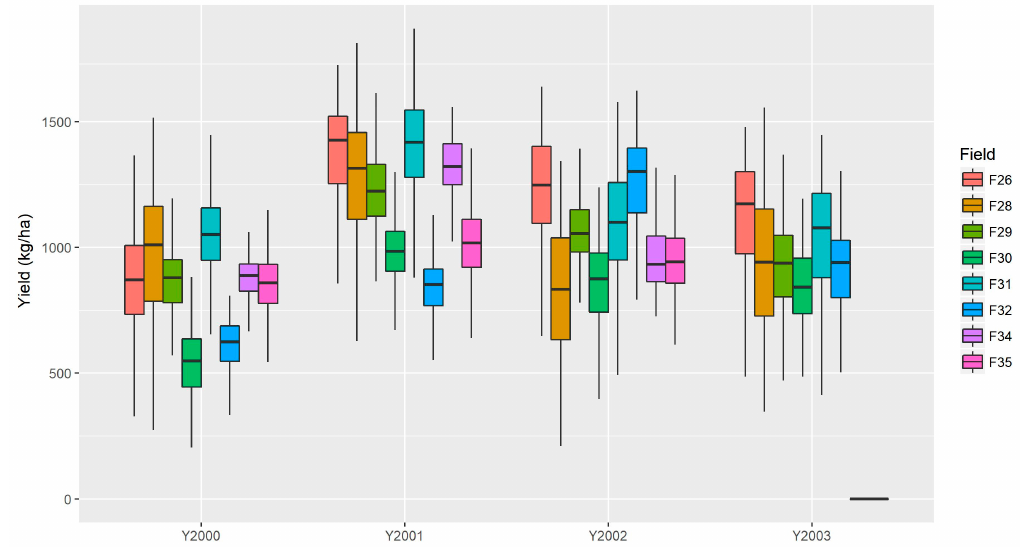
Figure 4. Cotton lint yield variability of eight fields in the Southern High Plains 2000 to